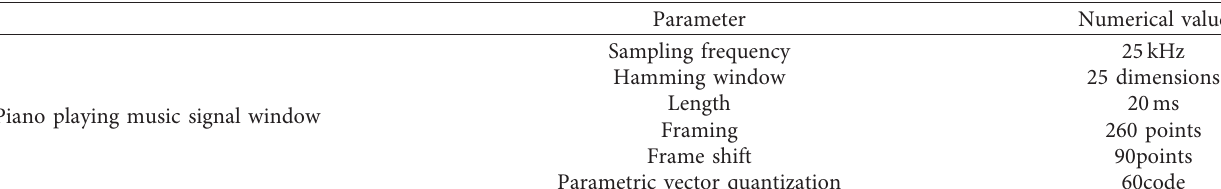
Table 1: Experimental parameter settings.